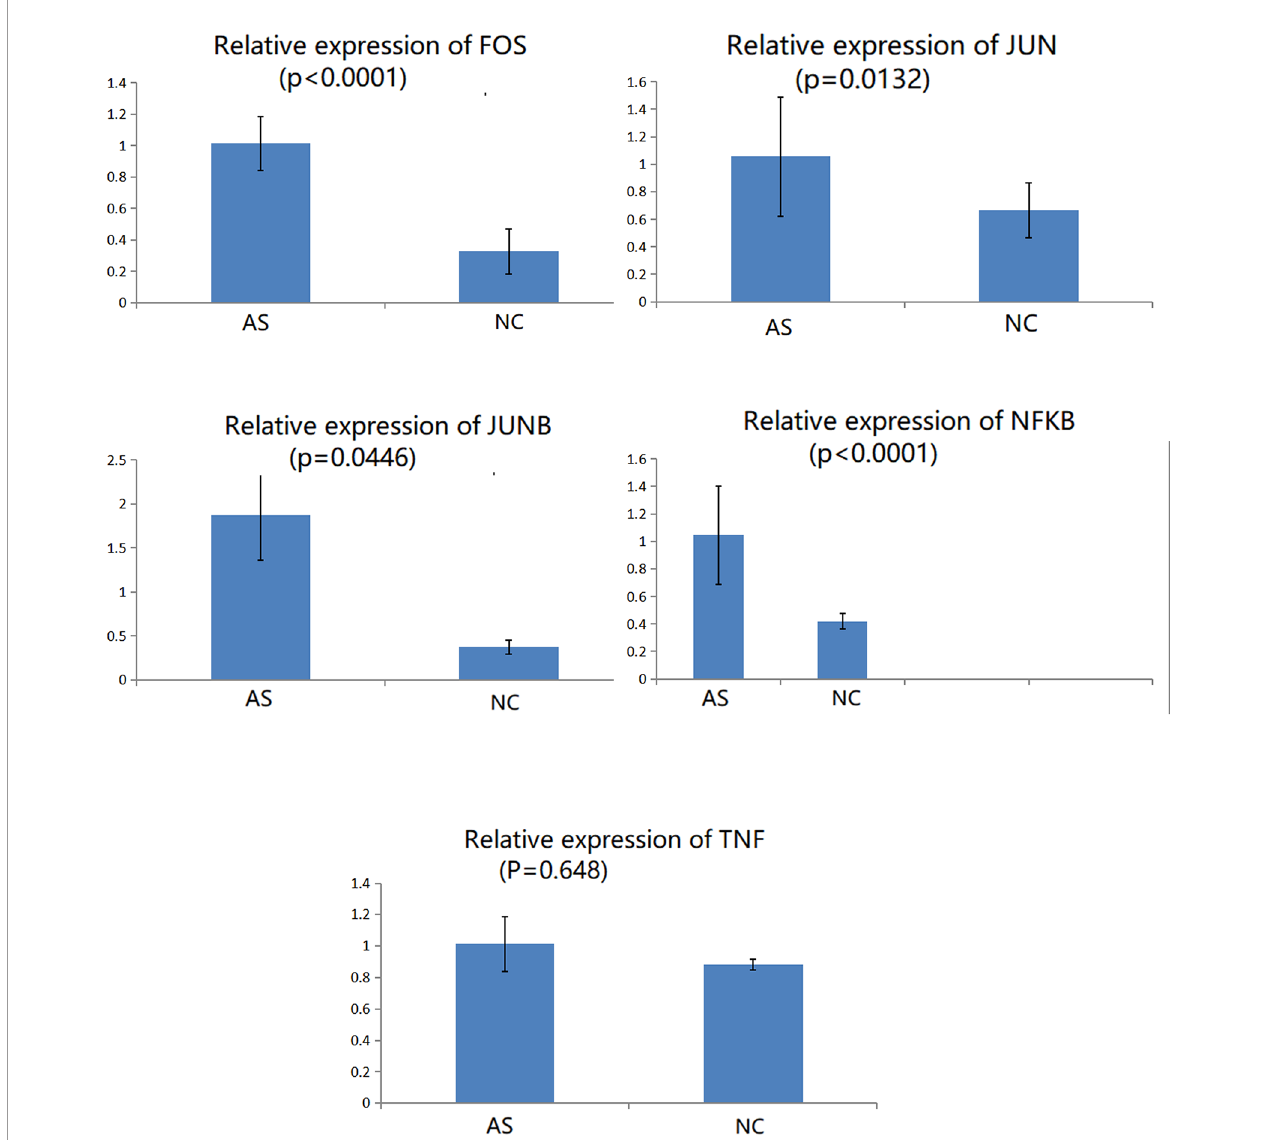
FIGURE 6 | Relative expression of genes in CD8+ T cells involved in the TNF signaling